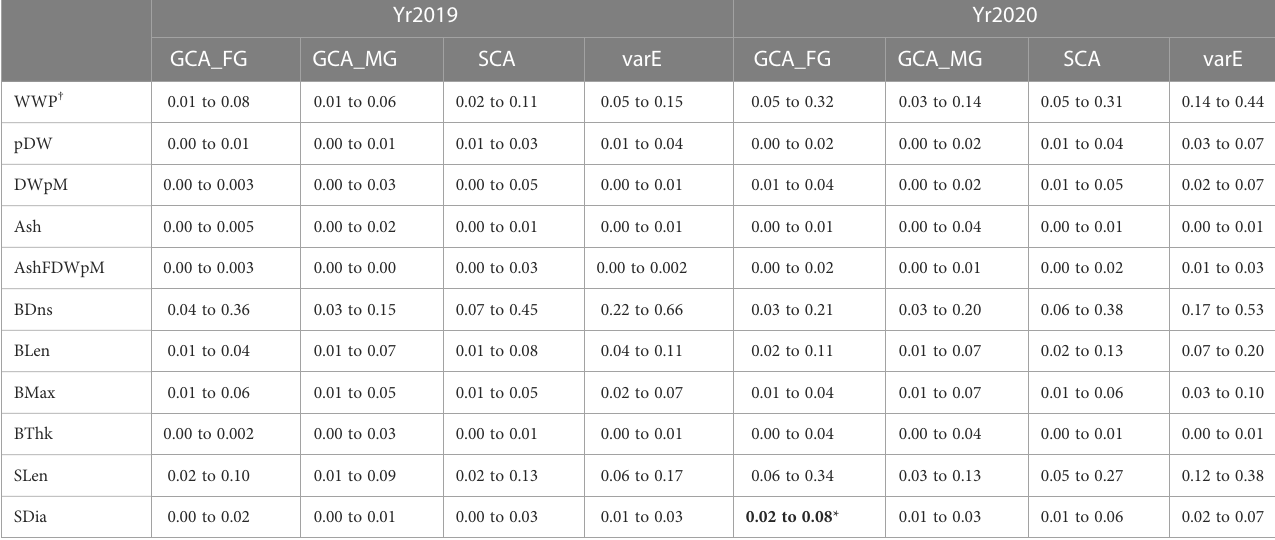
† For trait abbreviations refer to Table 1. * Bolded: For over 97.5% of posterior samples GCA_FG > GCA_MG. Model used within year BLUEs as input and the marker and pedigree based combined relationship matrix in BGLR.